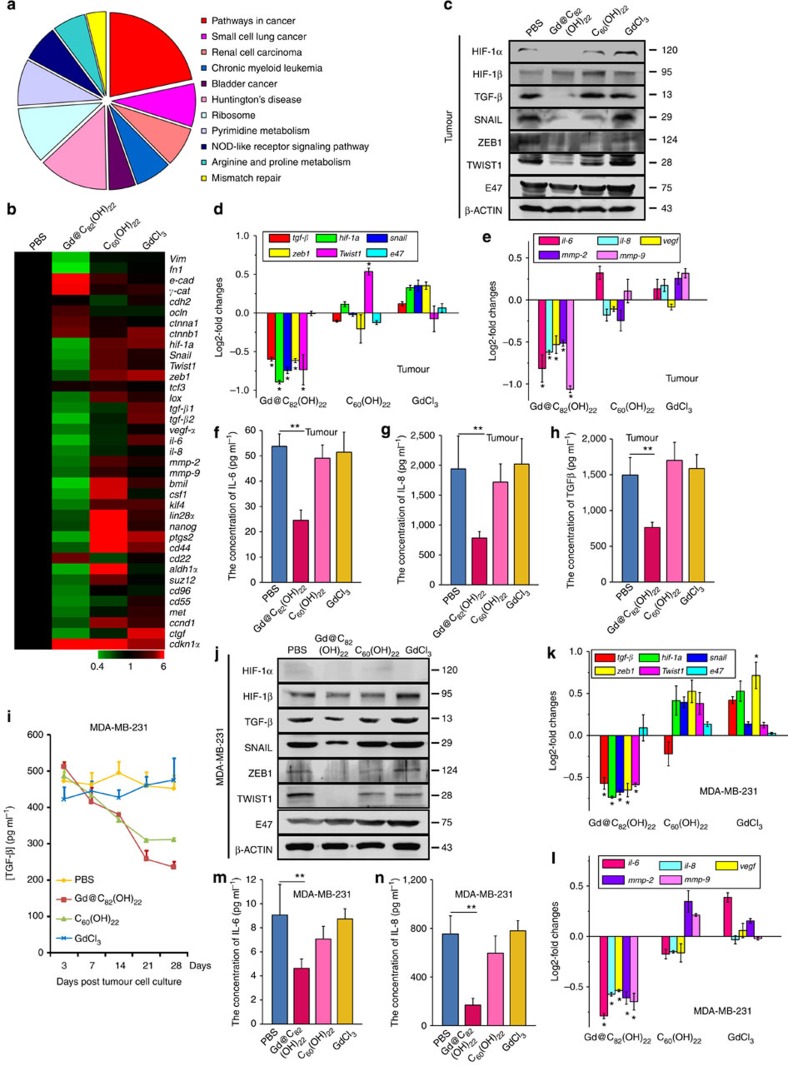
Pathway analysis of Gd@C82(OH)22 nanoparticles to impede EMT under normoxia.Cells were treated with PBS, Gd@C82(OH)22, C60(OH)22 or GdCl3 (all 50 μM) for 21 days. (a) KEGG pathway analysis of Gd@C82(OH)22 regulated genes by DAVID software. (b) Heat map depicting the mRNA expression profile of selected genes. Red squares correspond to increased expression, while green squares correspond to decreased expression of mRNA levels. MDA-MB-231 cells were subcutaneously injected into the mice at day 0. Mice were treated with either PBS or 2.5 μmol kg−1 Gd@C82(OH)22, C60(OH)22 or GdCl3 i.p., once a day before killing. (c) Protein levels of HIF-1α, HIF-1β, TGF-β, SNAIL, ZEB1, TWIST1 and E47 in tumour tissue were detected by western blot. (d) mRNA levels of tgf-β, hif-1α, snail, zeb1, twist1 and e47 in the tumour tissues were analysed by qPCR (mean±s.e.m., n=3 each). (e) mRNA levels of il-6, il-8, mmp-2, mmp-9 and vegf in the tumour tissues were analysed by qPCR (mean±s.e.m., n=3 each). (f–h) ELISA analysis for expression of IL-6, (f) IL-8 (g) and TGF-β (h) in the serum was determined. All the data are represented as mean±s.e.m. (n=3 each) with *P<0.05 and **P<0.01 (one-way ANOVA, Tukey’s post-hoc test). MDA-MB-231 cells were treated with PBS, Gd@C82(OH)22, C60(OH)22 or GdCl3 for 21 days. (i) ELISA analysis for expression of TGF-β levels in the MDA-MB-231 culture medium treated with Gd@C82(OH)22 at day 3, 7, 14, 21 and 28 (mean±s.e.m., n=3 each). *P<0.05 (two-way ANOVA, Bonferroni’s post-hoc test). (j) Protein expression of HIF-1α, HIF-1β, TGF-β, SNAIL, ZEB1, TWIST1 and E47 were detected by western blot. (k) mRNA levels of tgf-β, hif-1α, snail, zeb1, twist1 and e47 were analysed by qPCR (mean±s.e.m., n=3 each). (l) mRNA levels of il-6, il-8, mmp-2, mmp-9 and vegf were analysed by qPCR (mean±s.e.m., n=3 each). ELISA analysis for IL-6 (m) and IL-8 (n) concentrations in the supernatant derived from cell culture medium. All the data are represented as mean±s.e.m. (n=3 each) with *P<0.05 and **P<0.01 (one-way ANOVA, Tukey’s post-hoc test).